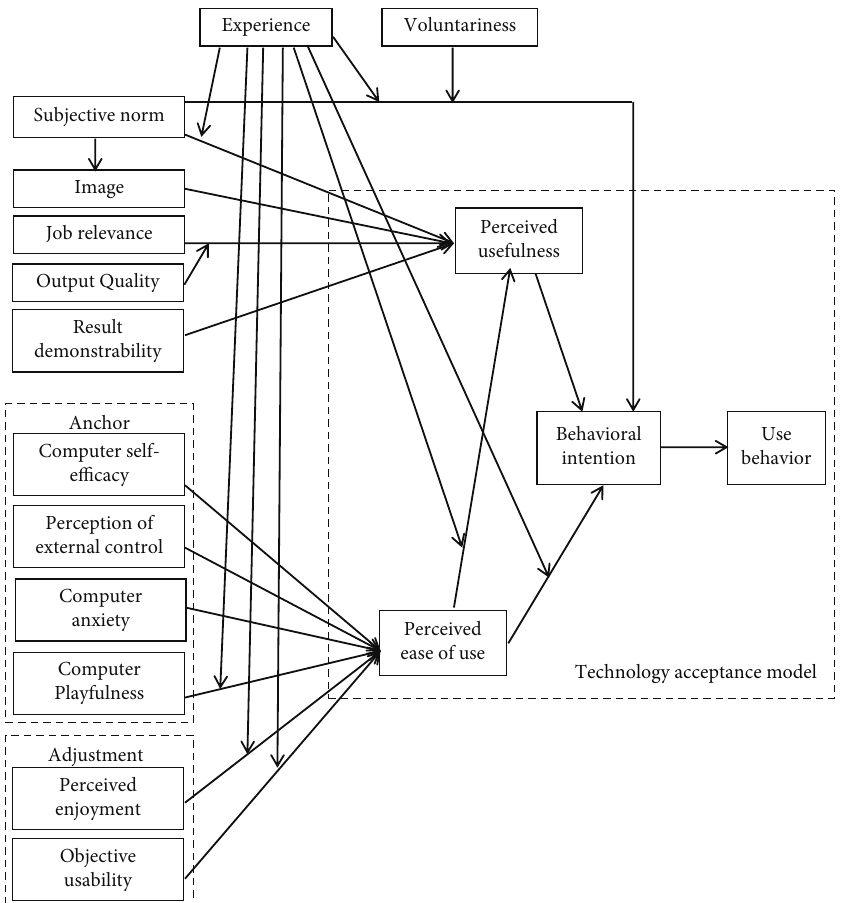
Figure 13: Technology acceptance model (TAM 3) [37].